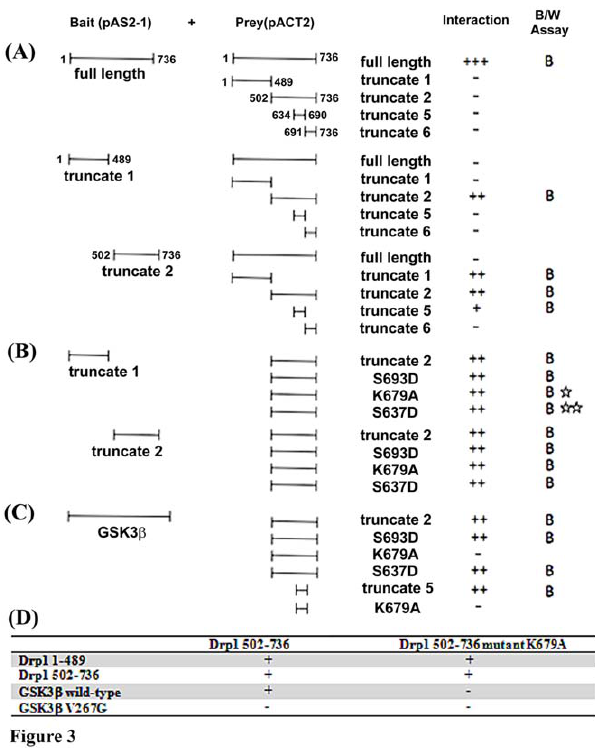
Figure 3. Yeast two-hybrid assay identifying Drp1 inter-/intra- interaction and residue responsible for GSK3beta-Drp1 bind- ing. The design of the yeast two-hybrid assays showing interactions of various bait (pAS2-1) or prey (pACT2) constructs is indicated. The strength of interaction was assayed as described in Methods. beta- galactosidase and HIS3 induction was quantified as described in Materials and Methods. The result of the interaction was shown by ‘‘ + ’’ or ‘‘ 2 ’’. (A) The inter-molecular interaction of Drp1 was tested by using full-length Drp1 as bait and various truncated Drp1 as prey to verify their interacting ability. The intra-molecular interaction of Drp1 was tested by using truncate 1 or 2 of Drp1 as bait and various truncated Drp1 as prey to verify their interacting ability. (B) Drp1 truncated fragments with point-mutation were tested to verify their interaction with Drp1 truncate 1 or 2. Some of our results were inconsistent with previous reports [14,23] and are indicated as ‘‘ q ’’and ‘‘ qq ’’, respec- tively (C). Some Drp1 truncate 2 mutants were tested for their possible interaction with GSK3beta. (D) Matrix of yeast two-hybrid assays showing interactions of various Drp1 N- and C-terminal deletion fragments, GSK3beta wt and GSK3beta V276G mutant in bait constructs, tested against C-terminal Drp1 prey constructs with or without K679A mutation as indicated. The result of interaction was shown as ‘‘ + ’’ or ‘‘ 2